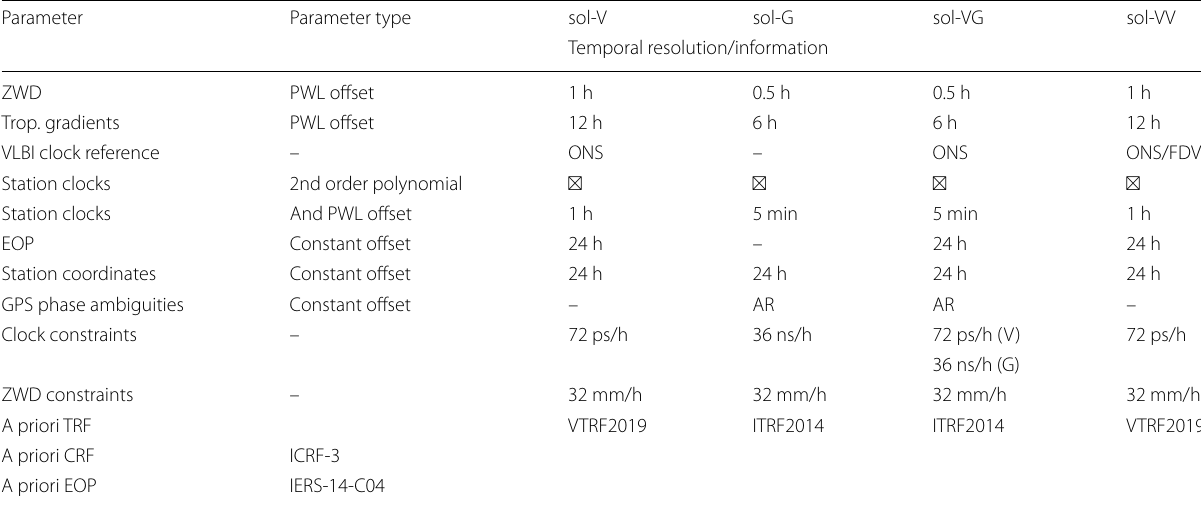
Presented are parameter type and temporal resolution that are used for the four different solutions. ONS and FDV stand for the VLBI station ONSALA60 and FD-VLBA, respectively. AR refers to constant offsets with non canonical timelengths as calculated by the GPS phase ambiguity resolution mode of c5